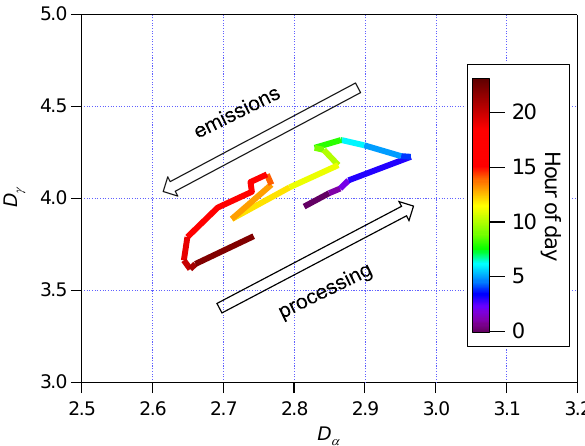
Figure 7. The relationship between average single particle diversity ( D α ) and average bulk population diversity ( D γ ) values sorted by hour of the day ( N = 26